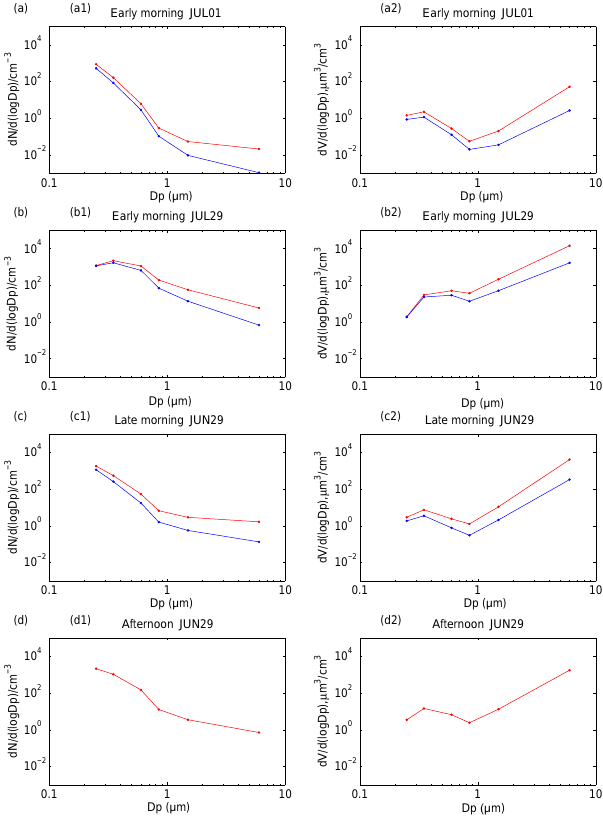
Figure 7. Aerosol number and volume size distributions in the mixed layer (red) and residual layer (blue), in the early morning of 1 July (a) and 29 July (b) , late morning of 29 June (c) , and af- ternoon of 29 June (d) flights. The mixed layer and residual layer heights are determined using the method of aerosol number concen- tration